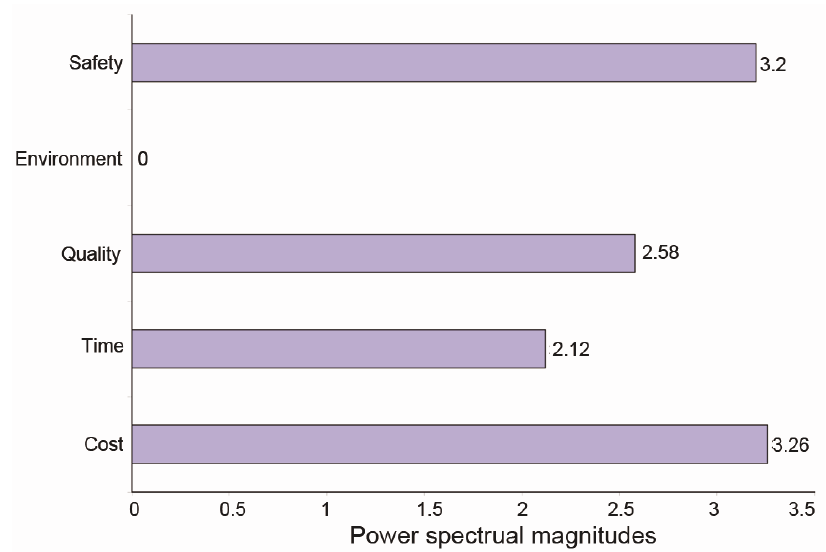
Fig. 3. Importance of project scopes